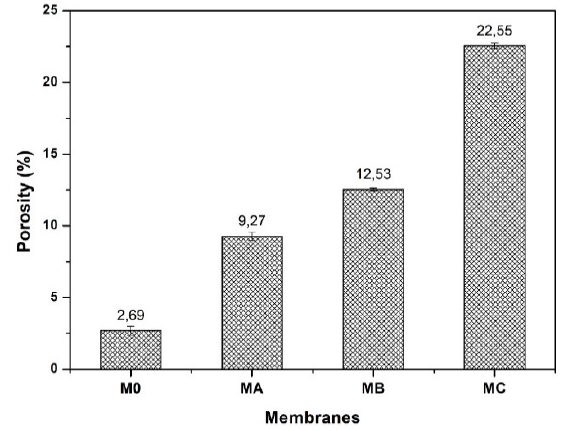
Figure 5. E ff ects of dopamine addition on membrane Figure 5. Effects of dopamine addition on membrane porosity.